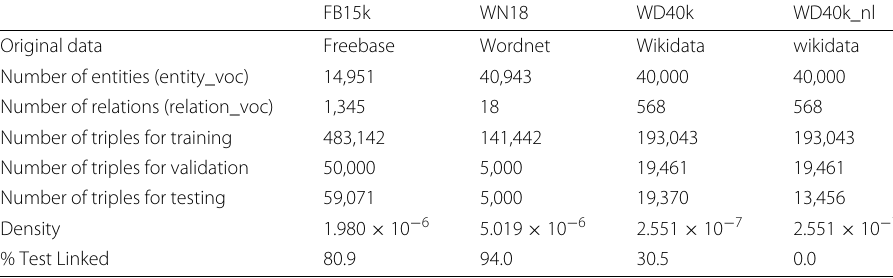
Table 1 Details of FB15k, WN18, WD40k and WD40k_nl FB15k WN18 WD40k